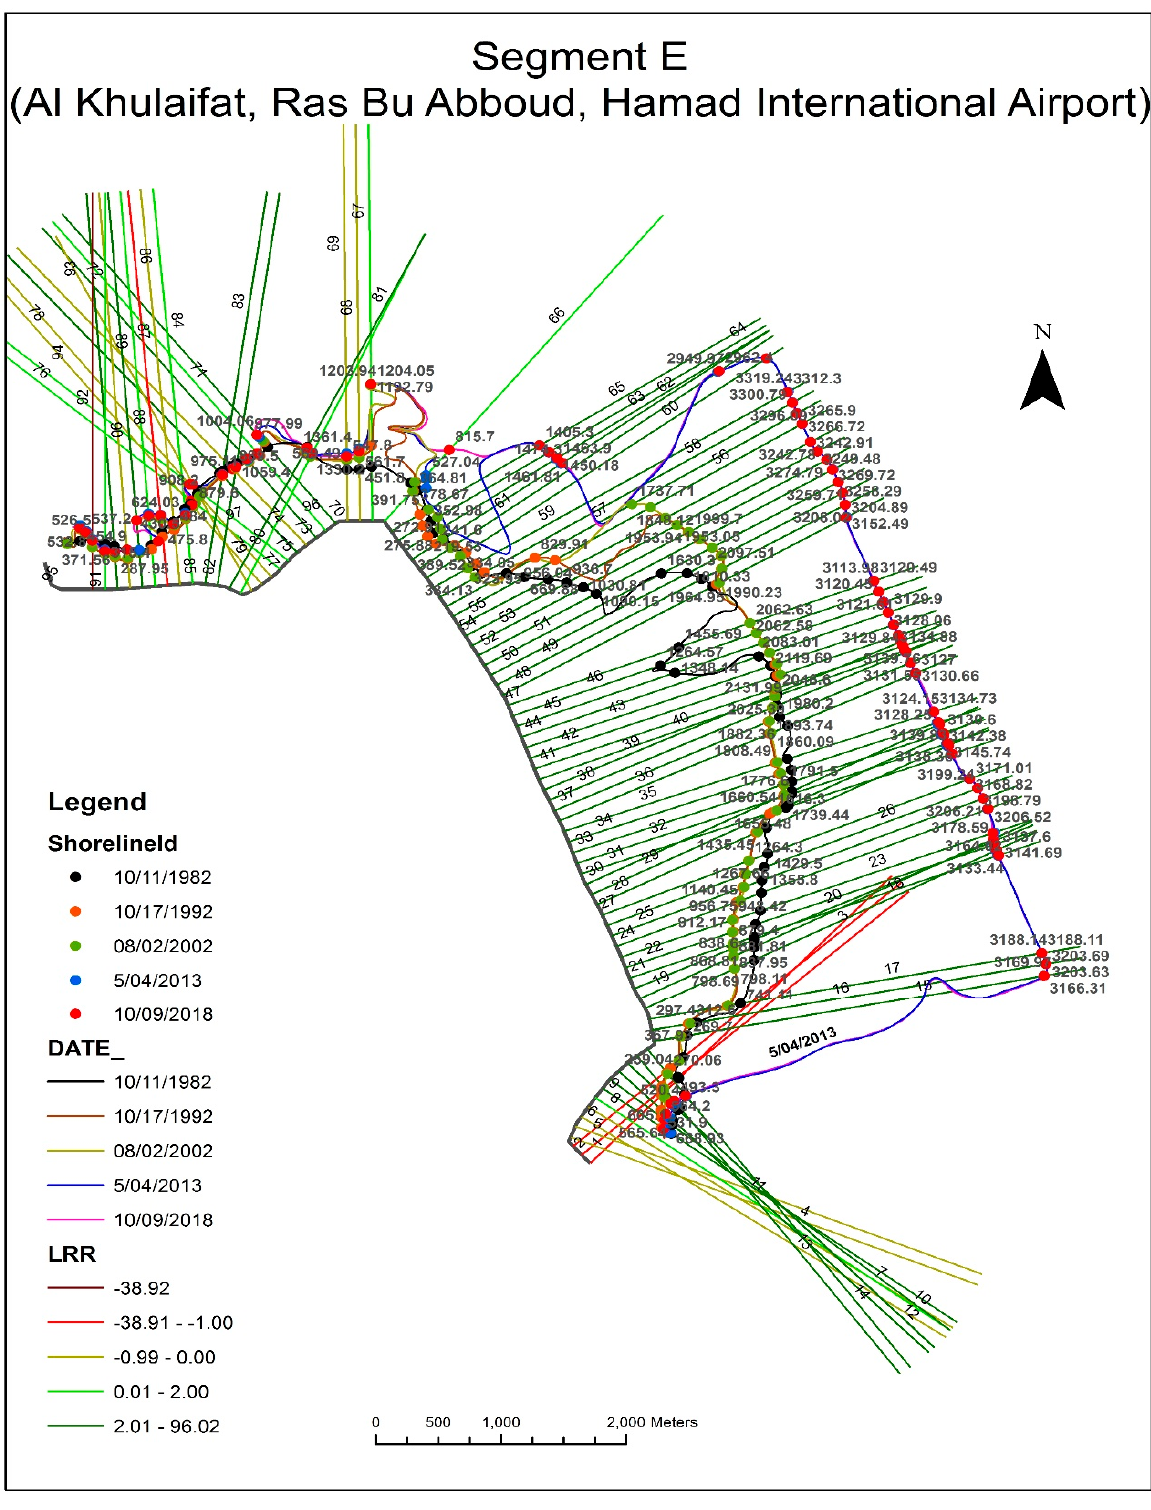
Figure 18. Shoreline of Al Khulaifat, Ras Bu Abboud, and Hamad International Airport.